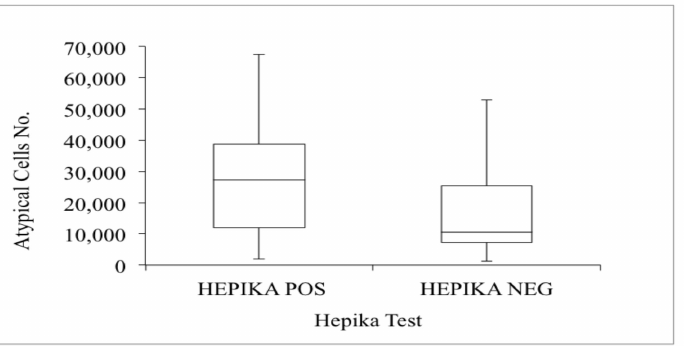
Figure 5. Distribution of atypical cells by Hepika test result. Data are presented in boxes and whiskers’ style, which represents the medians and ranges of the data. (Abbreviations: POS: positive; NEG: negative).